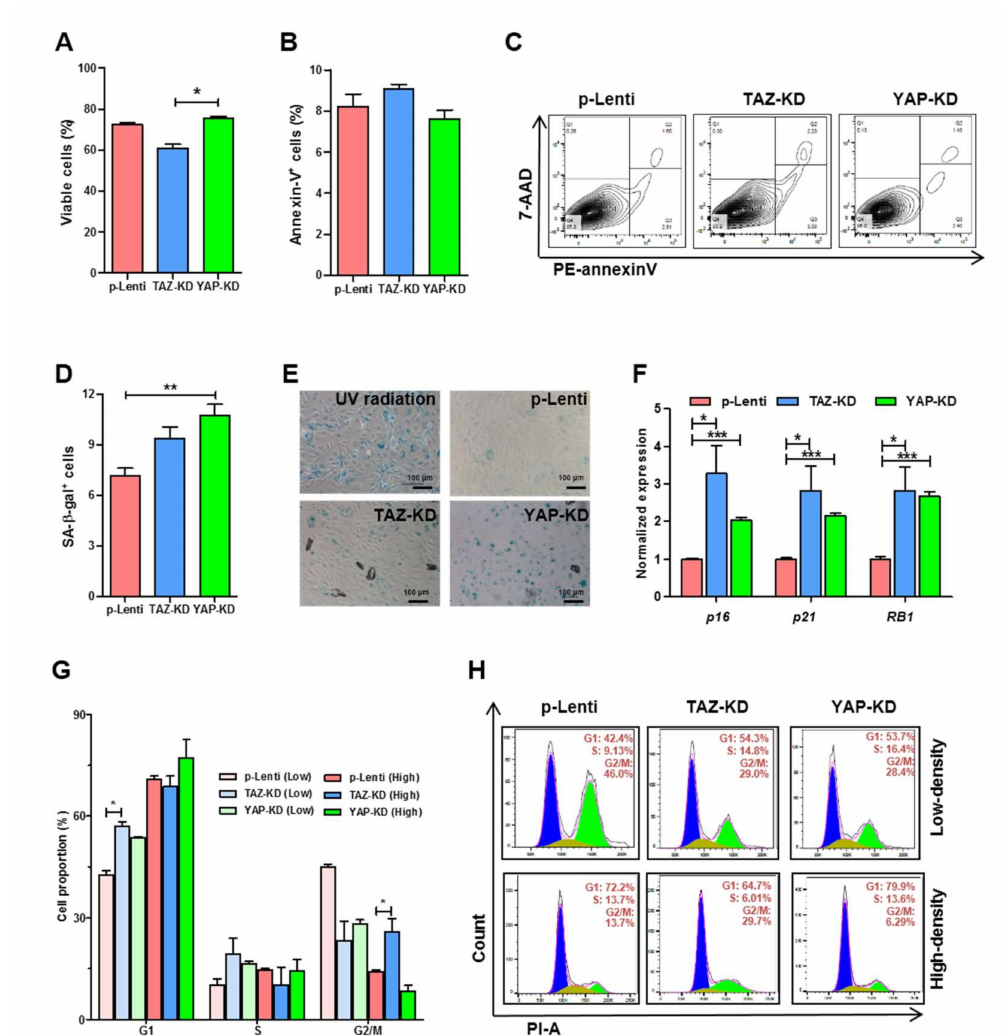
Figure 3. Survivability of YAP and TAZ-depleted EPCs. EPCs were synchronized by serum- starvation before seeding on fibronectin-coated wells before analyzing basal cell apoptosis ( A – C ) and β -galactosidase-positive senescent cells. 200 µ M cisplatin was used as a positive control ( D , E ). Tran- script levels of genes encoding cell cycle inhibitors; p16 , p21 , and RB1 in control and KD EPCs were performed by RT-qPCR ( F ). Cell cycle analysis of control and KD-EPCs were determined by staining DNA contents with propidium iodide and analyzed by FACS analysis ( G , H ). All experiments were performed thrice independently with technical duplicates, and data were expressed as mean ± SEM. * p -value < 0.05; ** p -value < 0.01; and *** p -value <